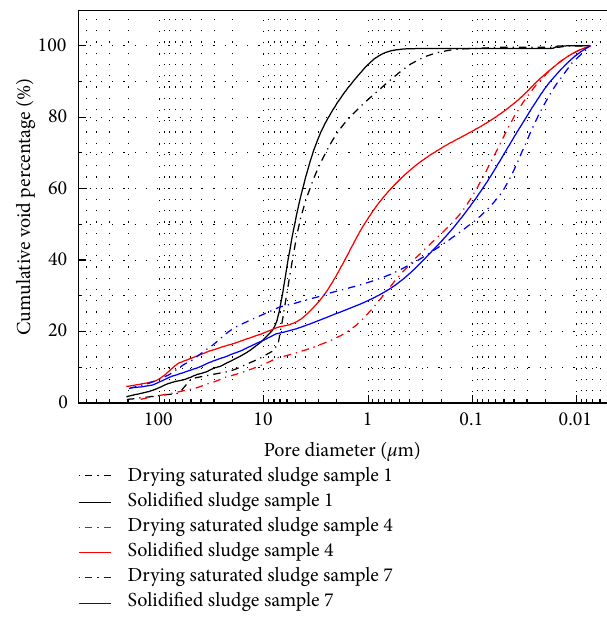
Figure 7: Cumulative pore volume of solidified sludge with different initial moisture contents.